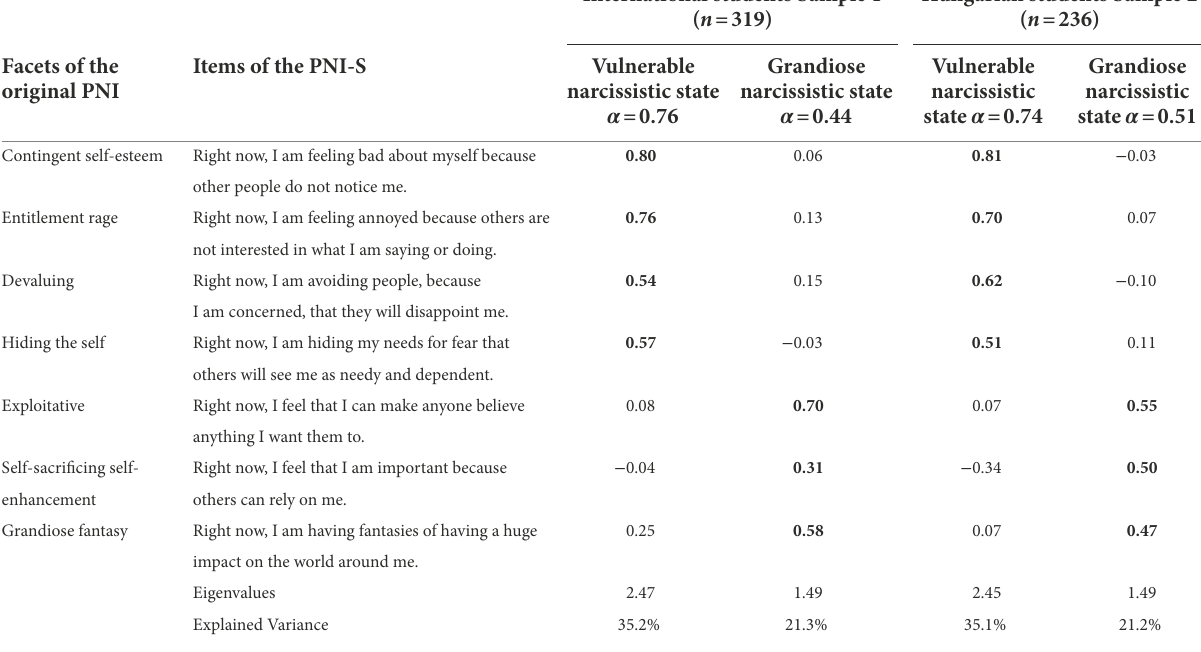
TABLE 1 Items of the PNI-S with the related facets from the original PNI and an exploratory factor analysis of the PNI-S in the international and Hungarian samples.